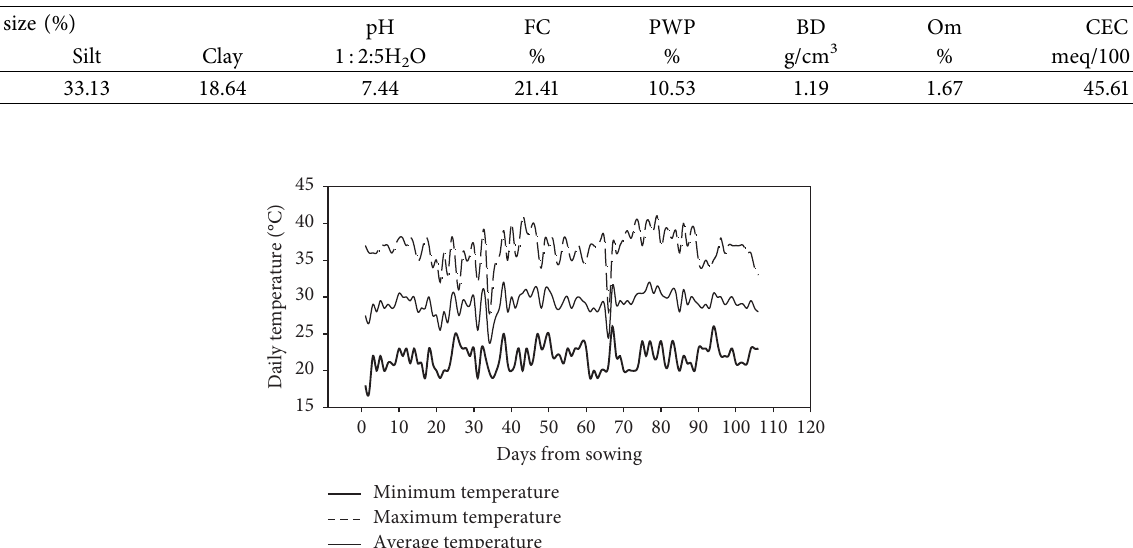
Table 1: Some physical and chemical properties of the soil used for the experiment.